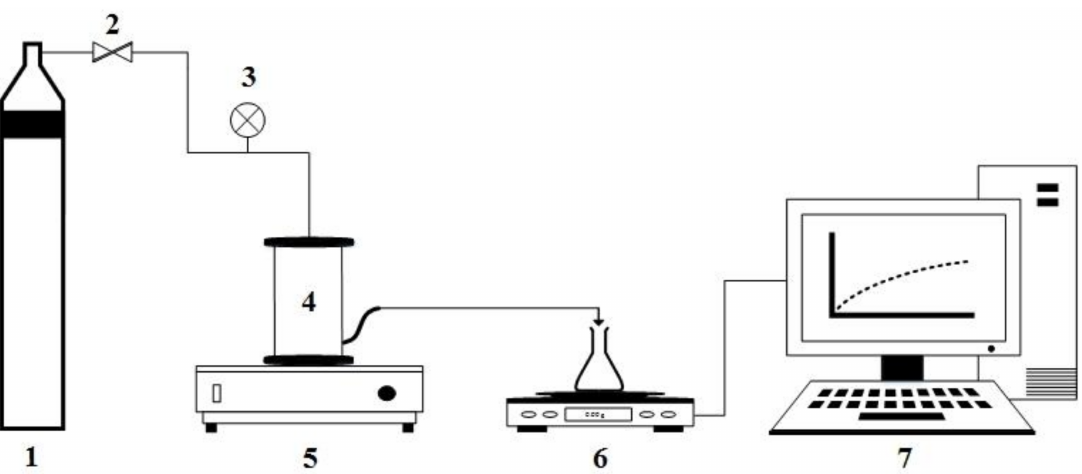
Figure 2. Frontal filtration experimental setup (1—nitrogen gas bottle, 2—pressure regulator, 3—pressure indicator, 4— Membranology HP350 stirred cell, 5—magnetic stirrer plate, 6—weight balance, 7—computer data